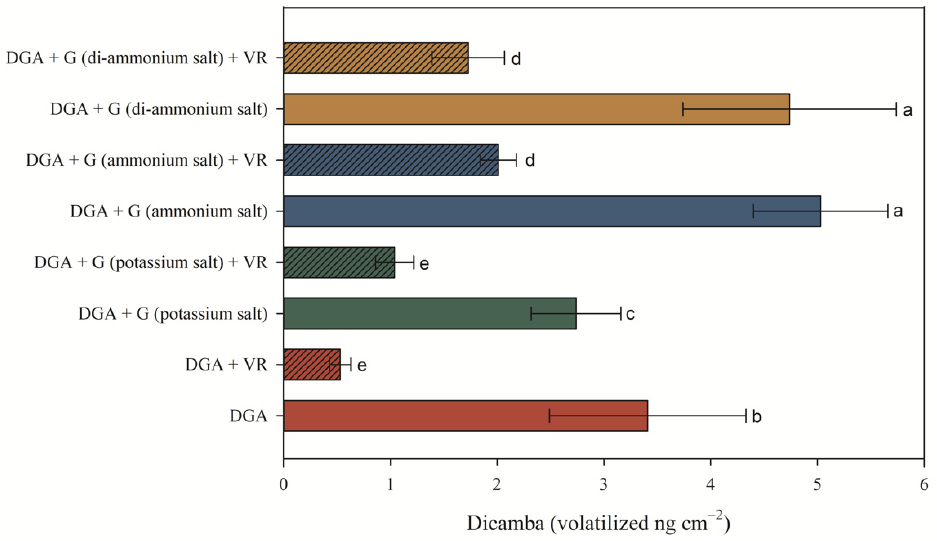
Figure 2. Volatilization of dicamba (ng cm − 2 ) alone and in combination with a volatility reducer and glyphosate formulations (potassium, ammonium, and di-ammonium salts). The error bars represent the confidence interval ( p ≤ 0.05). Averages followed by the same letter do not differ from each other according to LSD test ( p ≤ 0.05). VR: volatility reducer; DGA: dicamba diglycolamine salt; G: glyphosate.